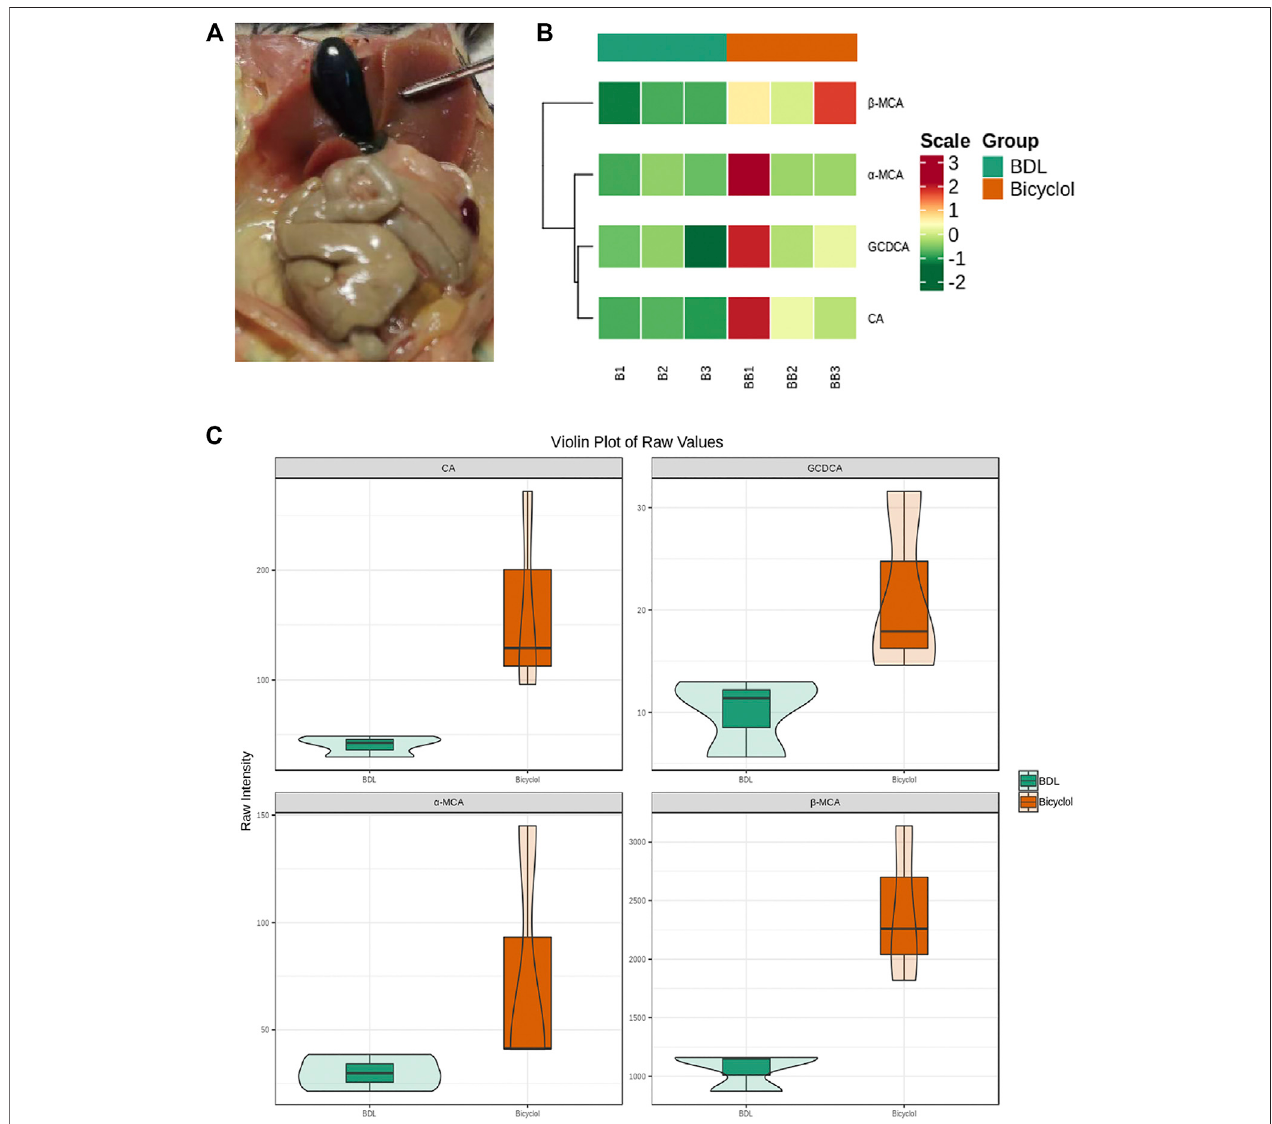
FIGURE 2 | Bile acid composition in the gallbladder. (A) The gallbladder of BDL mice. (B) Heatmap of differential bile acids of gallbladder bile samples. Rows represent different bile acids, while columns represent different samples. Colors from green to red indicate increasing levels from low to high. (C) Violin plot analysis comparing the levels of CA, GCDCA, α -MCA, β -MCA in the BDL and Bicyclol groups. Green represents the BDL group, whereas orange represents the Bicyclol group.